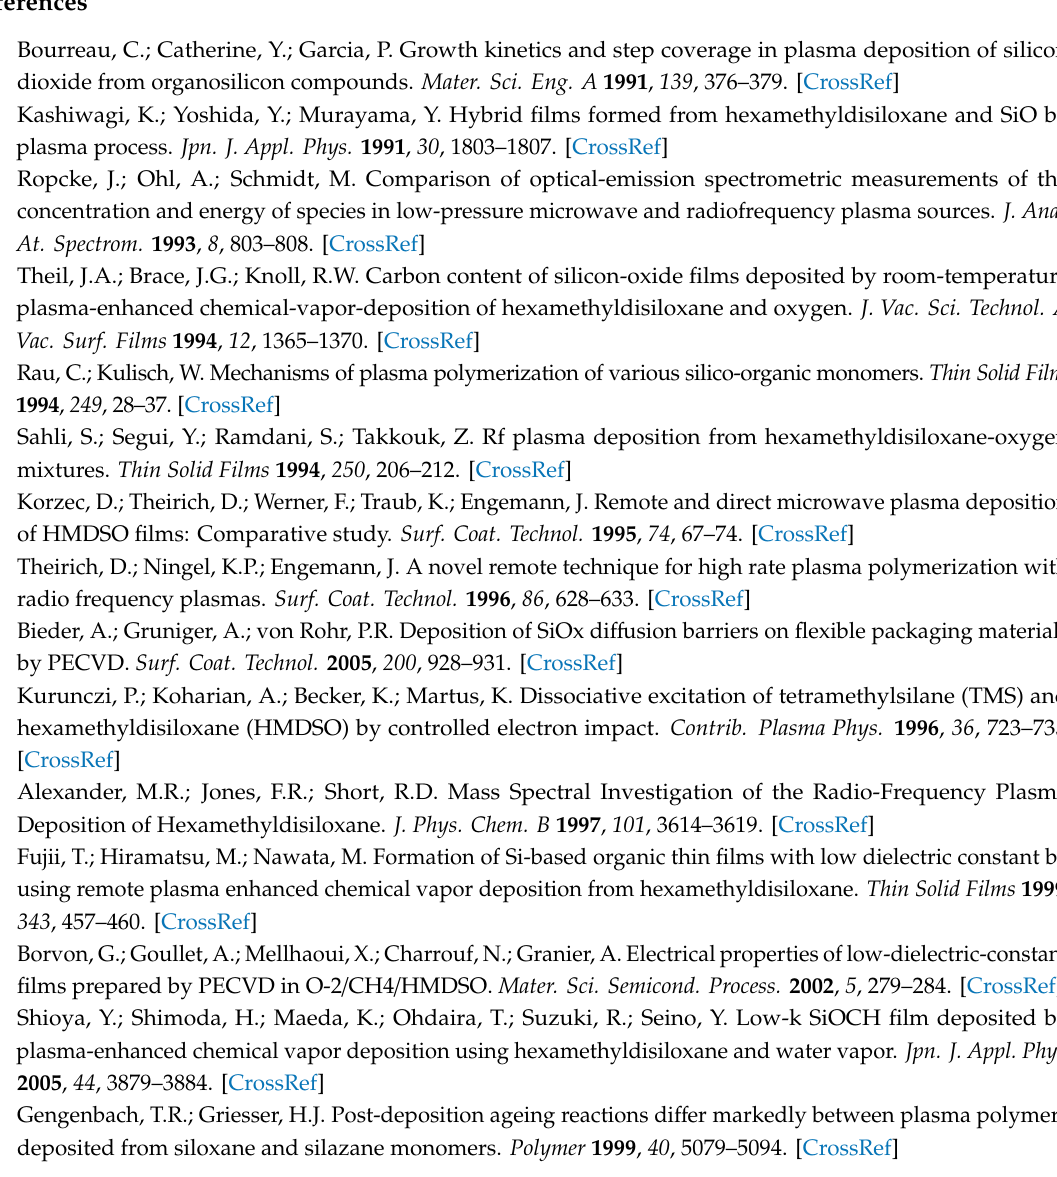
Figure S1: Comparison of XPS spectra of the coating with the reference samples of PDMS and SiO 2 for ( a ) C1s, ( b ) O1s, and ( c ) Si2p, and detailed surface spectra of the coating with subcomponents for ( d ) C1s, ( e ) O1s, and ( f )